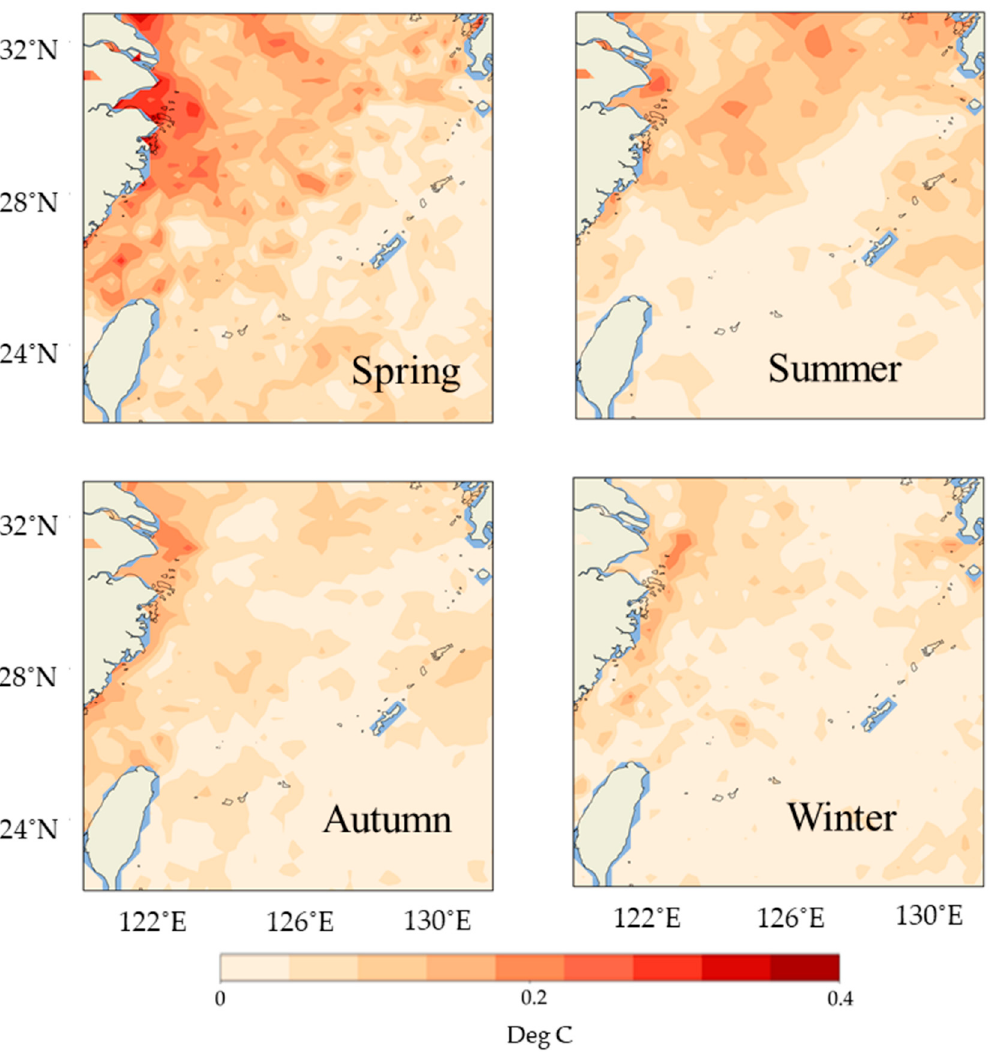
Figure 10. Spatial distribution of AE of OSTIA data and LSTM predictions of SST in four seasons, in which spring is from March to May, summer is from June to August, autumn is from September to November, and winter is from December to February. The unit of colorbar is degrees Celsius.